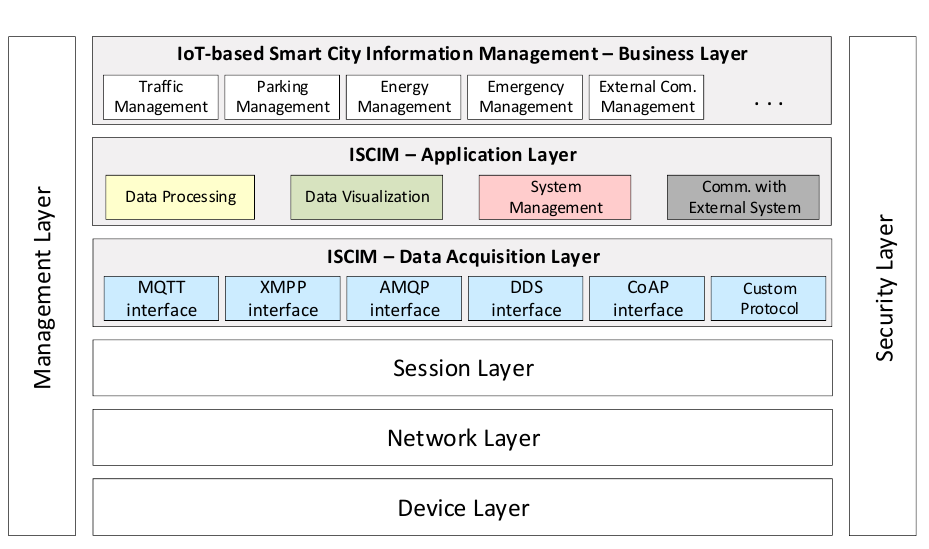
Figure 5. Reference Layered View for IoT-Based Smart City Inf. Man. Systems.